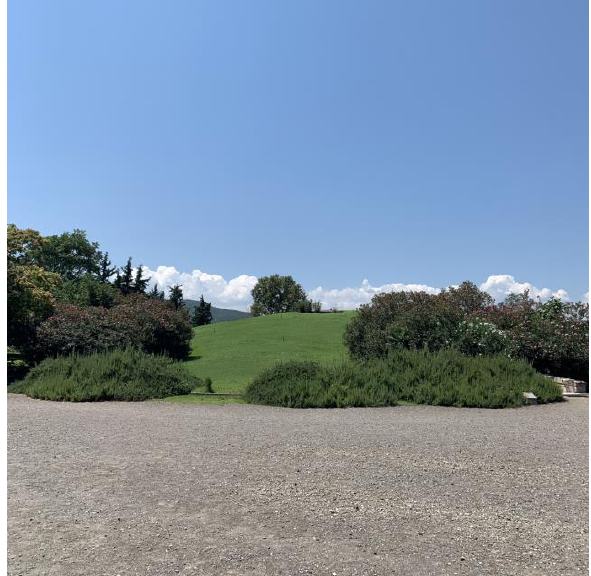
Figure 1. View of the Great Mound at Verghina, where the Royal Tombs are located. Photos by the